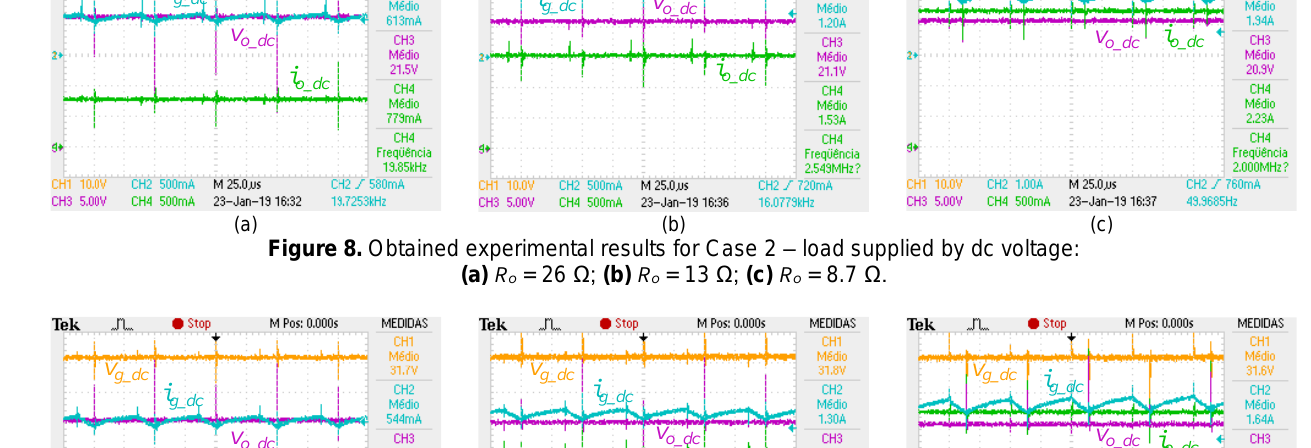
Figure 7. Obtained experimental results for Case 1 – load supplied by ac voltage: